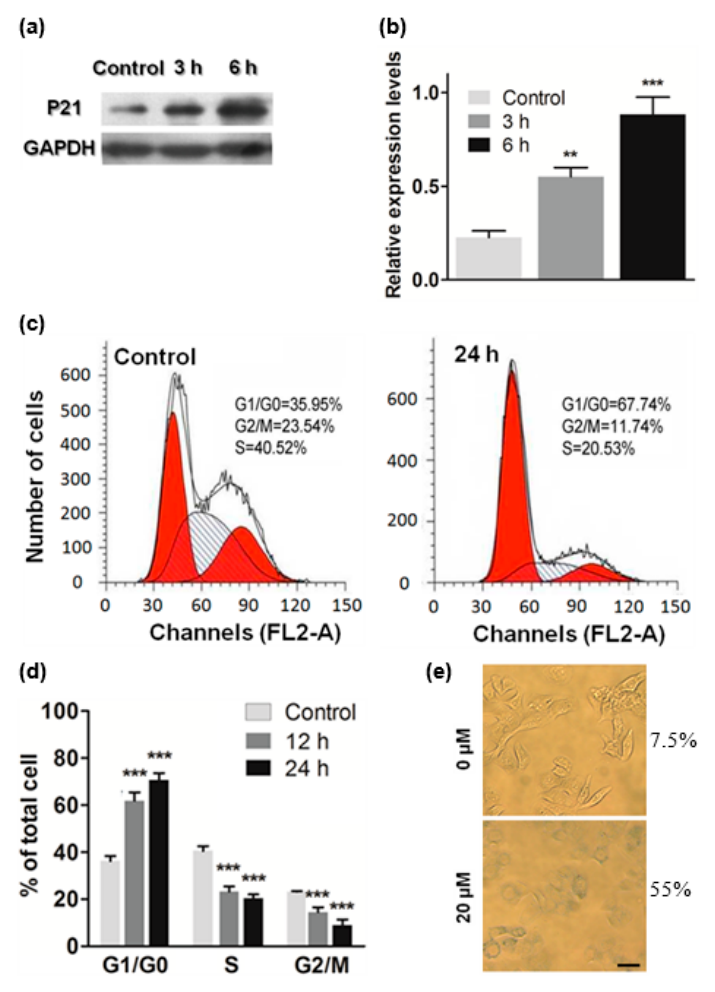
Figure 4. ATL treatment arrested the cell cycle at G 1 . ( a , b ) Western blot analysis of p21: treatment with 40 μ M ATL for 3 h and longer increased the level of p21 in the colorectal cancer cells (** p < 0.01, *** p < 0.001 vs. vehicle control); ( c , d ) Examination of cell cycle by flow cytometry: the percentage of cells in G 1 phase (left red area) was increased, while those in S (slash shaded area) and G 2 /M phases (right red area) were decreased by 40 μ M ATL treatment (*** p < 0.001 vs. vehicle control) (note: the subG 1 population was excluded from these analyses); ( e ) Detection of senescent cells: 20 μ M ATL treatment for 48 h increased the percentage of cells with senescence-associated beta-galactosidase (SA- β -gal) activity (scale bar = 20 μ m).